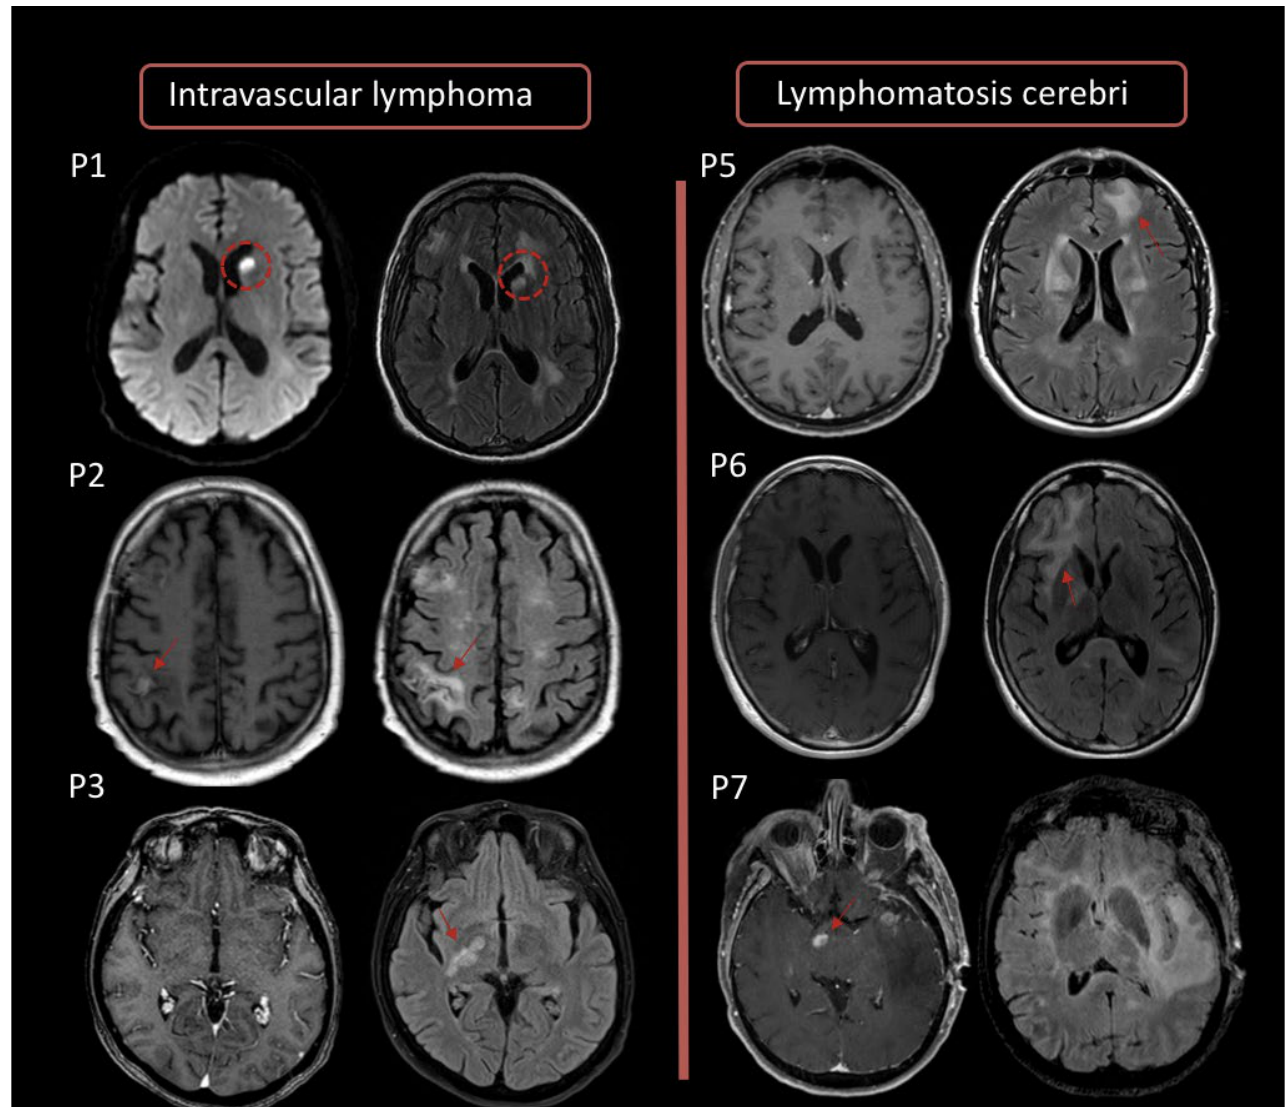
Figure 1. Case examples of MRI presentations of intravascular lymphoma (Patients 1, 2, and 3) and cerebral lymphomatosis (Patients 5, 6, and 7). Left : intravascular lymphoma presents as cortical, subcortical, or periventricular lesions with FLAIR hypersignal (2nd column) and little or no gadolinium-weighted T1+ enhancement. The diffusion-weighted image of the first patient ( P1 ) shows a high hypersignal of the head of the caudate nucleus mimicking a stroke (red dotted circle). Right : lesions of cerebral lymphomatosis appear as infiltrating, confluent lesions with FLAIR hypersignal, in the deep and subcortical white matter (red arrows), without mass effect (4th column). T1+ gadolinium-weighted images (3rd column) show no enhancement, with the exception of the last patient (bottom right) who had both typical homogeneous enhanced lesions and an infiltrating FLAIR hypersignal.